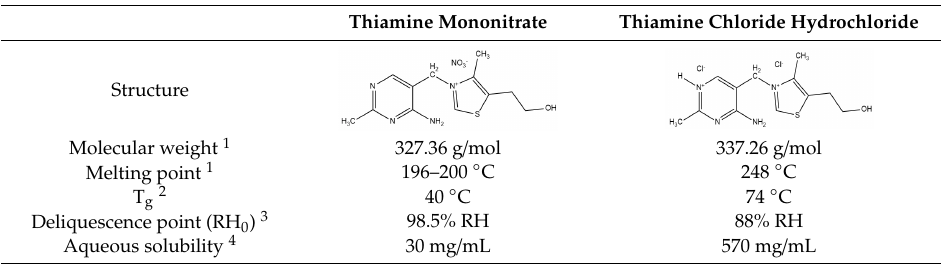
Table 3. Solid state property comparison between TMN and TClHCl.